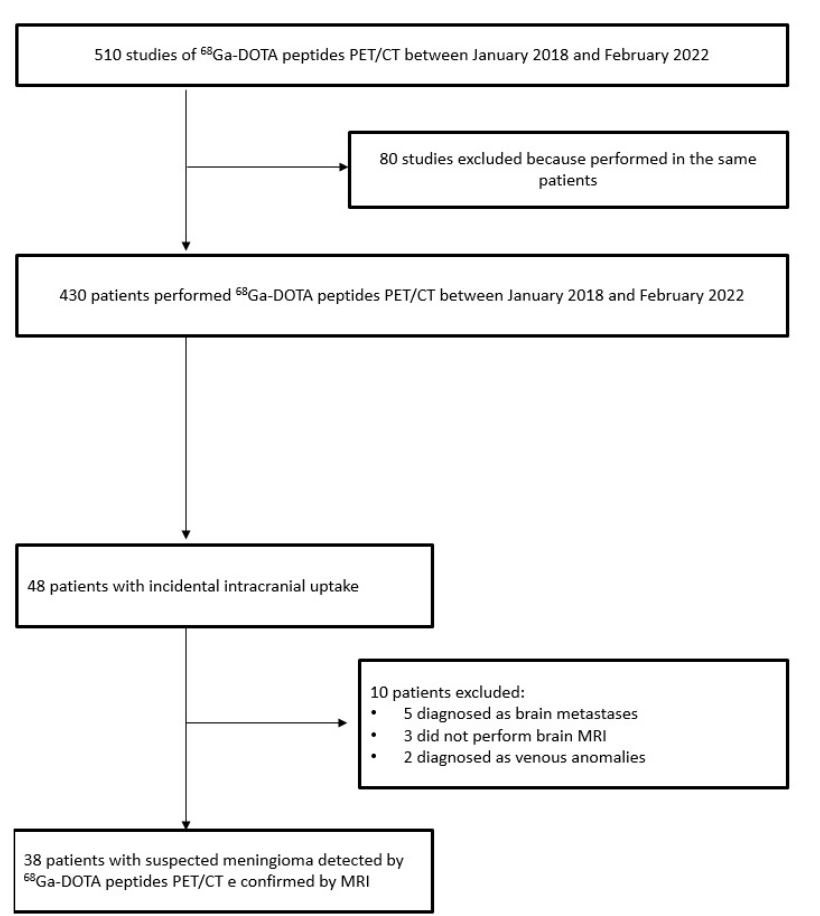
Figure 1. Flow chart of patients included in the study.